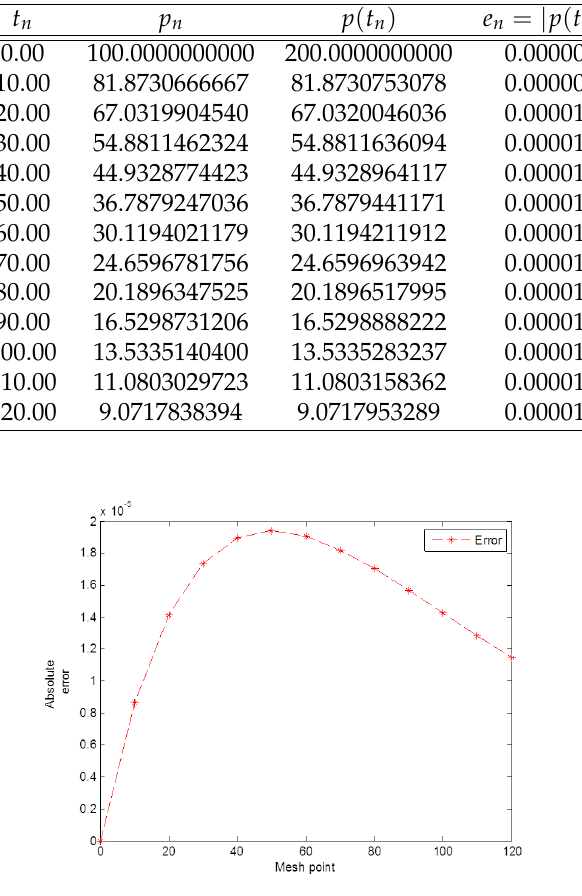
Figure 2. Errors generated via the scheme